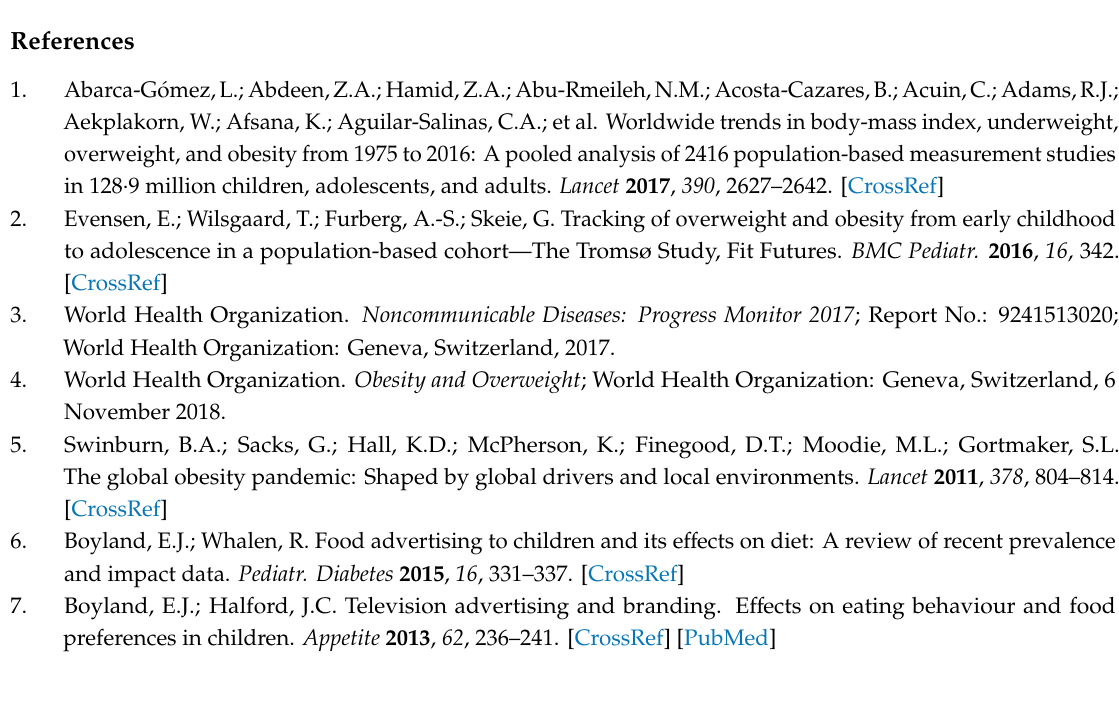
Table S1: Digital Games, Table S2: Endorsers, Table S3: Internet, Table S4: Packaging, Table S5: Print Advertising, Table S6: Television /